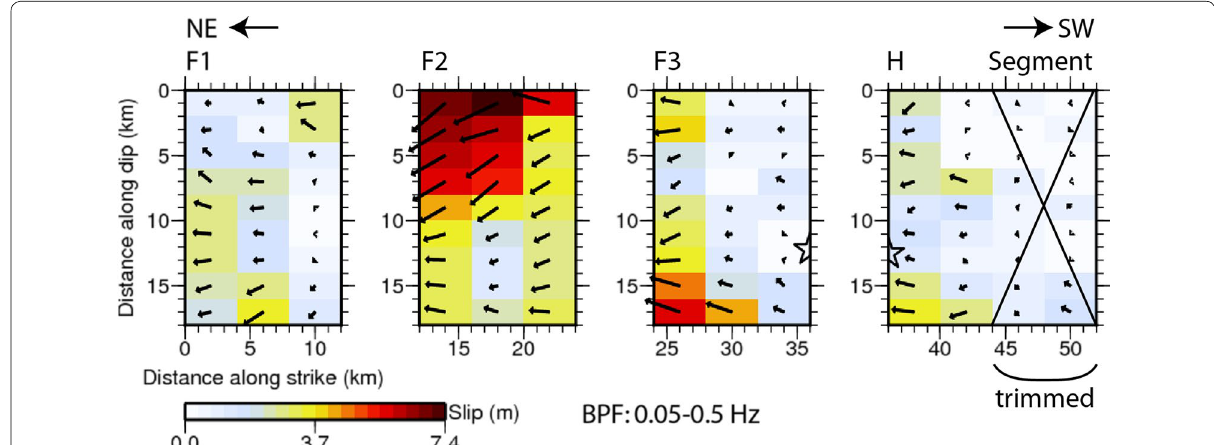
Fig. 4 Total slip distribution of the first-step inversion using 0.05–0.5 Hz band-pass strong-motion data. The two columns on the west side of the fault model were trimmed following the criteria by Somerville et al.